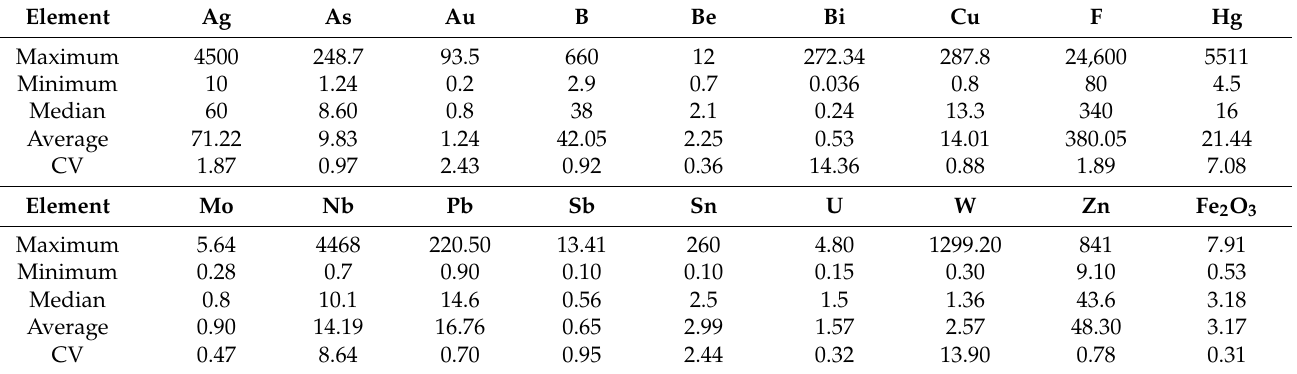
Table 1. Statistical parameters of 17 main ore-forming